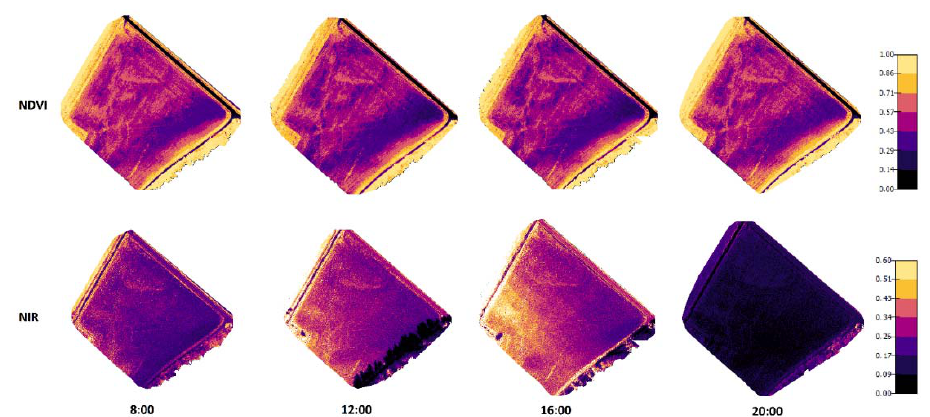
Figure 6. Orthomosaic maps for NDVI and NIR values of the Mölylä field at four measurement times. The measurements were taken on 31 July 2019 when the crop growth stage on spring barley was 87 (Zadoks value).